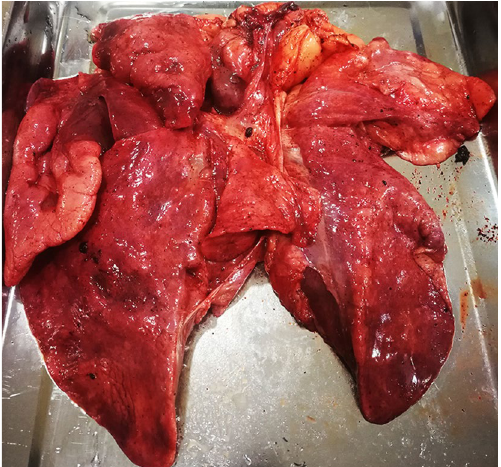
Figure 3. Gross observation of lung of Case 2. The lung presents dull-red, swelling, and liquid leakage from the section.